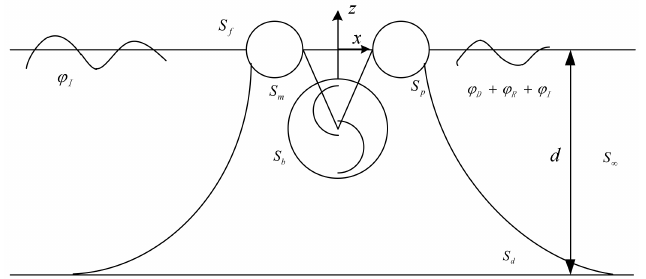
Figure 2. Computational domain of